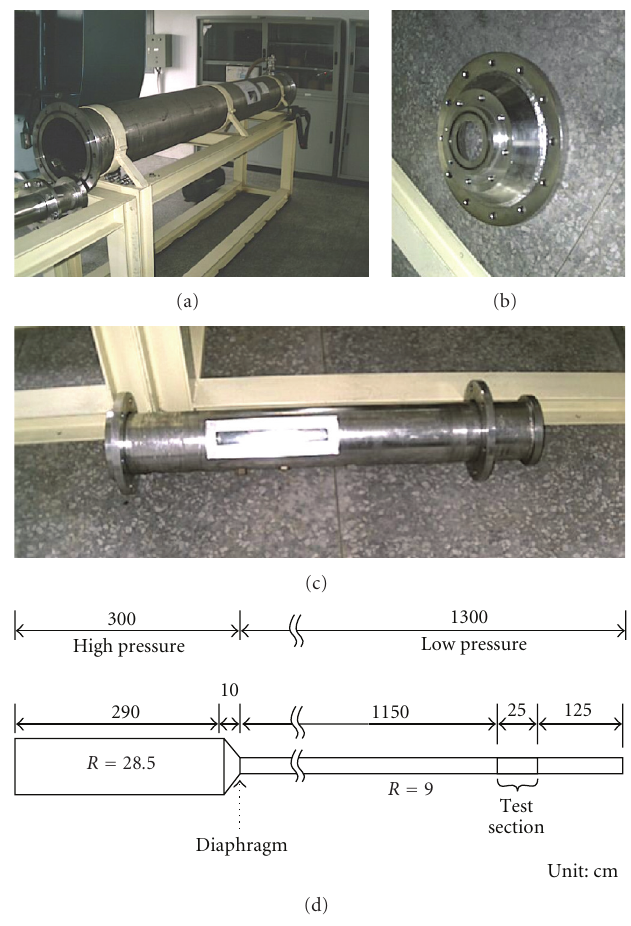
Figure 1: Shock tube dimension (a) high pressure sections (length: 290cm, diameter: 28.5 cm), (b) convergent nozzle space (length: 10cm, internal diameter in divergent section: 28.5 cm, internal diameter in convergent section: 9cm), (c) test section (window: 25cm × 3cm), (d)